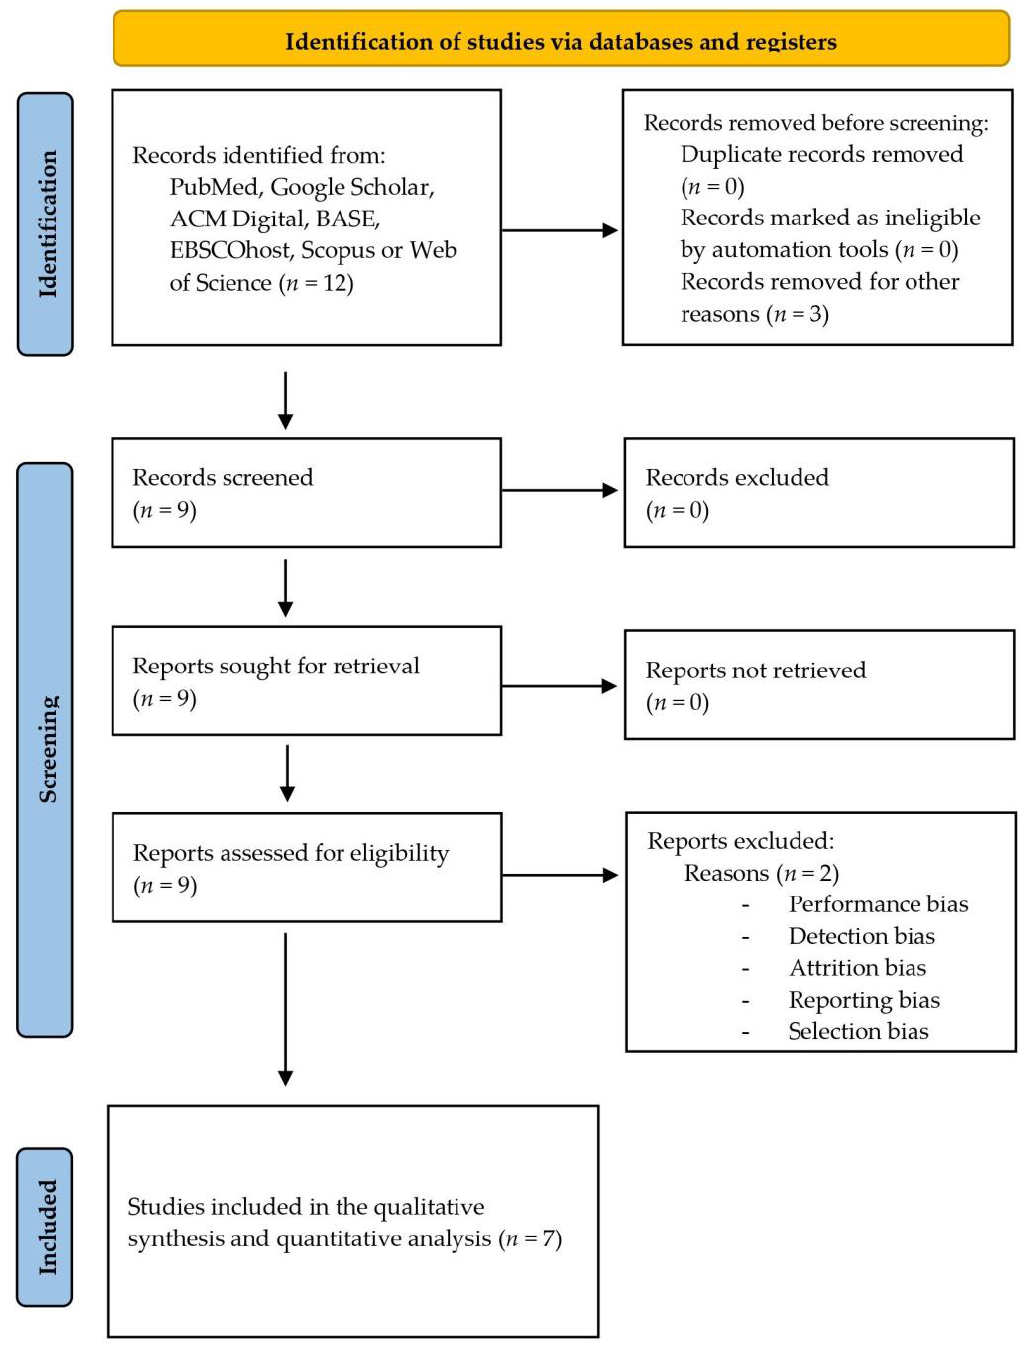
Figure 1. Study flow diagram.